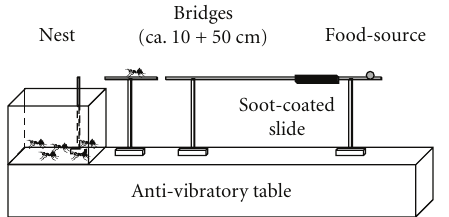
Figure 2: Schematic diagram of the experimental apparatus.